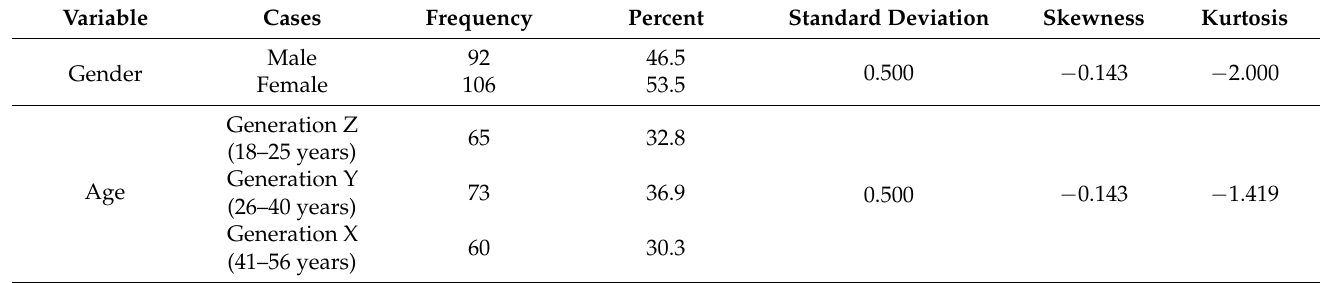
Table 1. Frequencies and descriptive statistics.